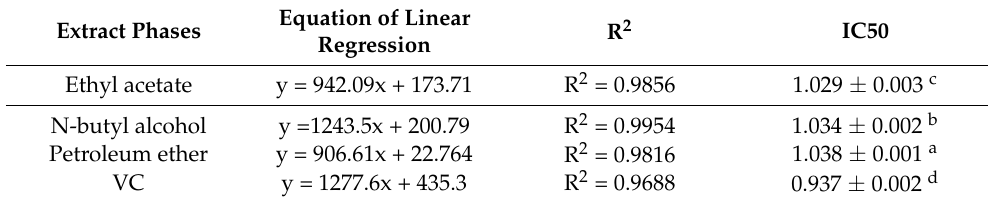
Table 12. FRAP values of Pleioblastus amarus (Keng) shell with different extraction phases. Extract